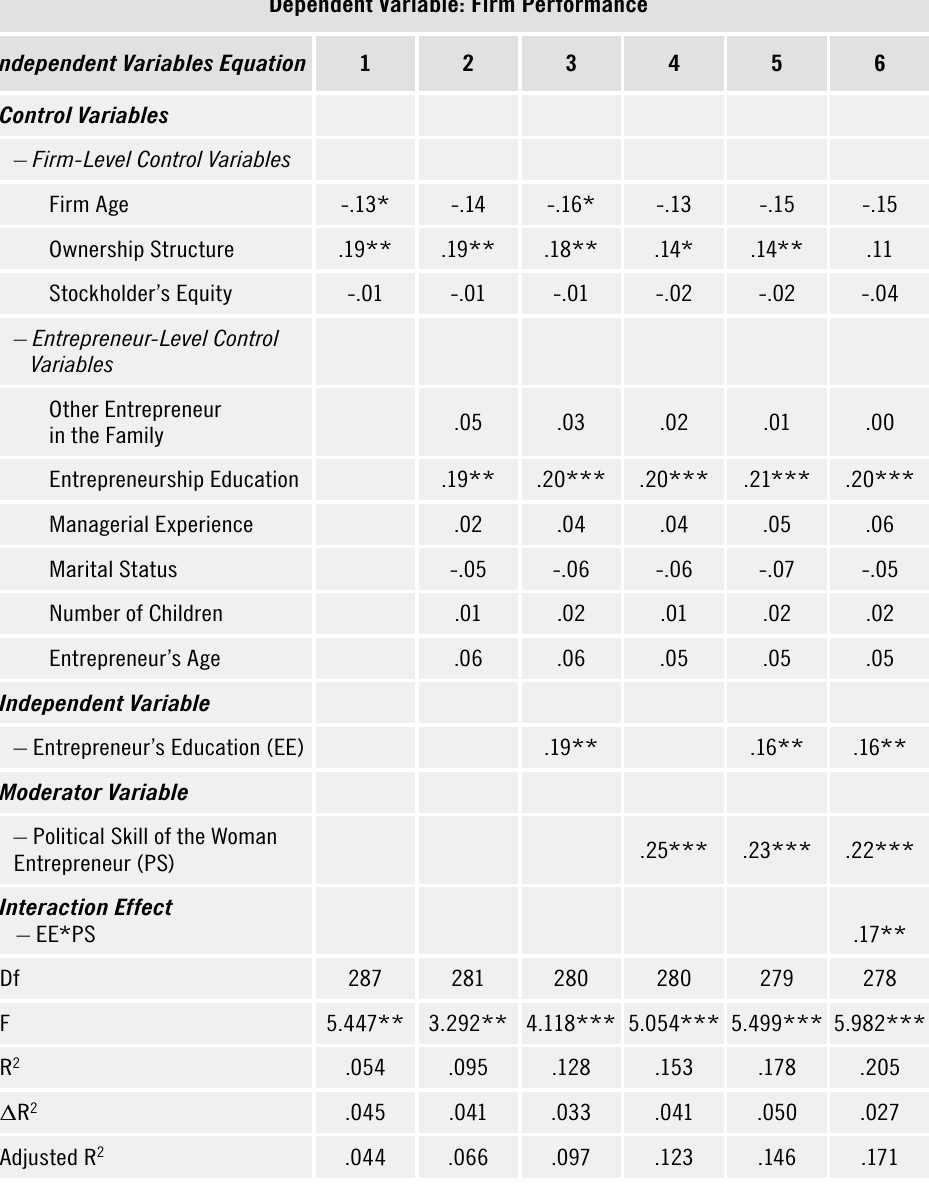
Table 3. Hierarchical regression results for the political skill of the woman entrepreneur and firm